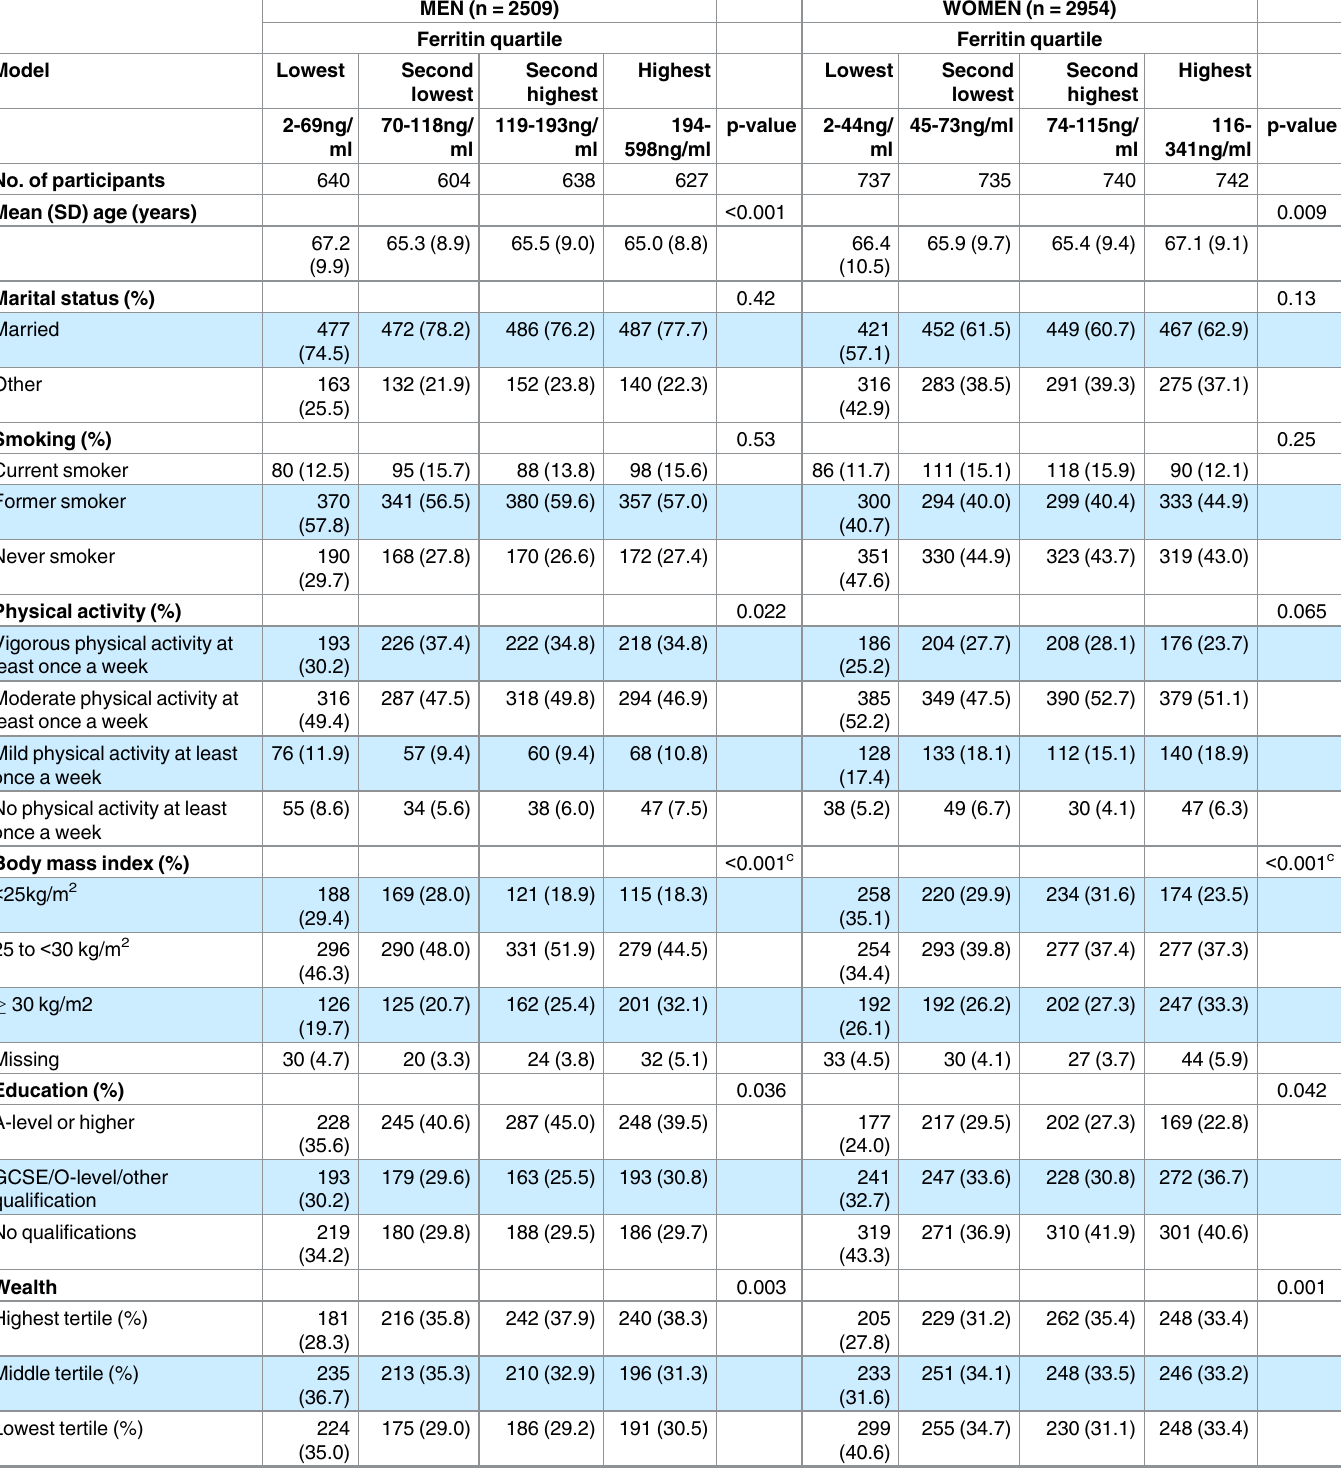
Table 1. Baseline characteristics of men and women aged 50 years and over by ferritin